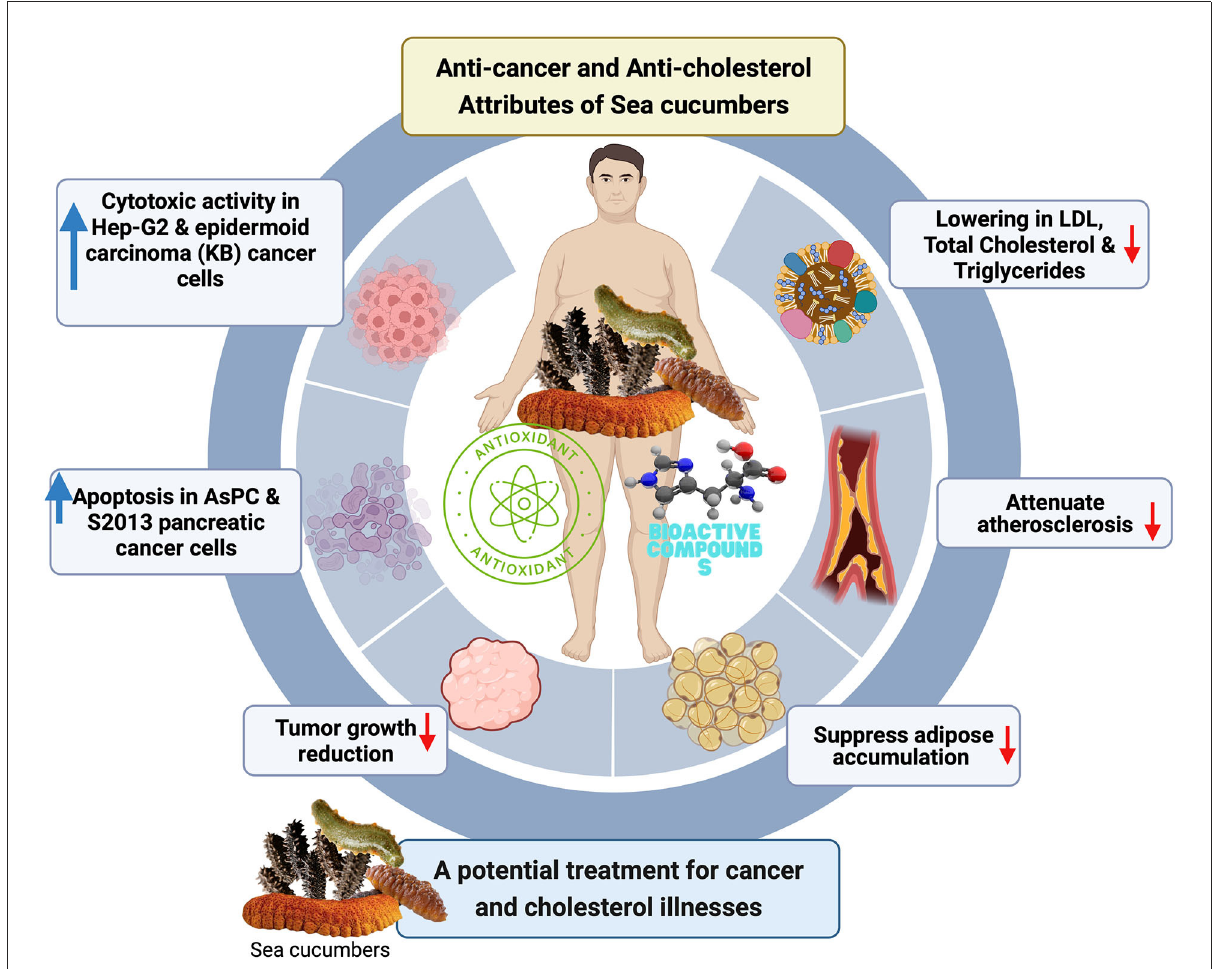
FIGURE1 Sea cucumbers effect possible-scheme for anti-cancer and